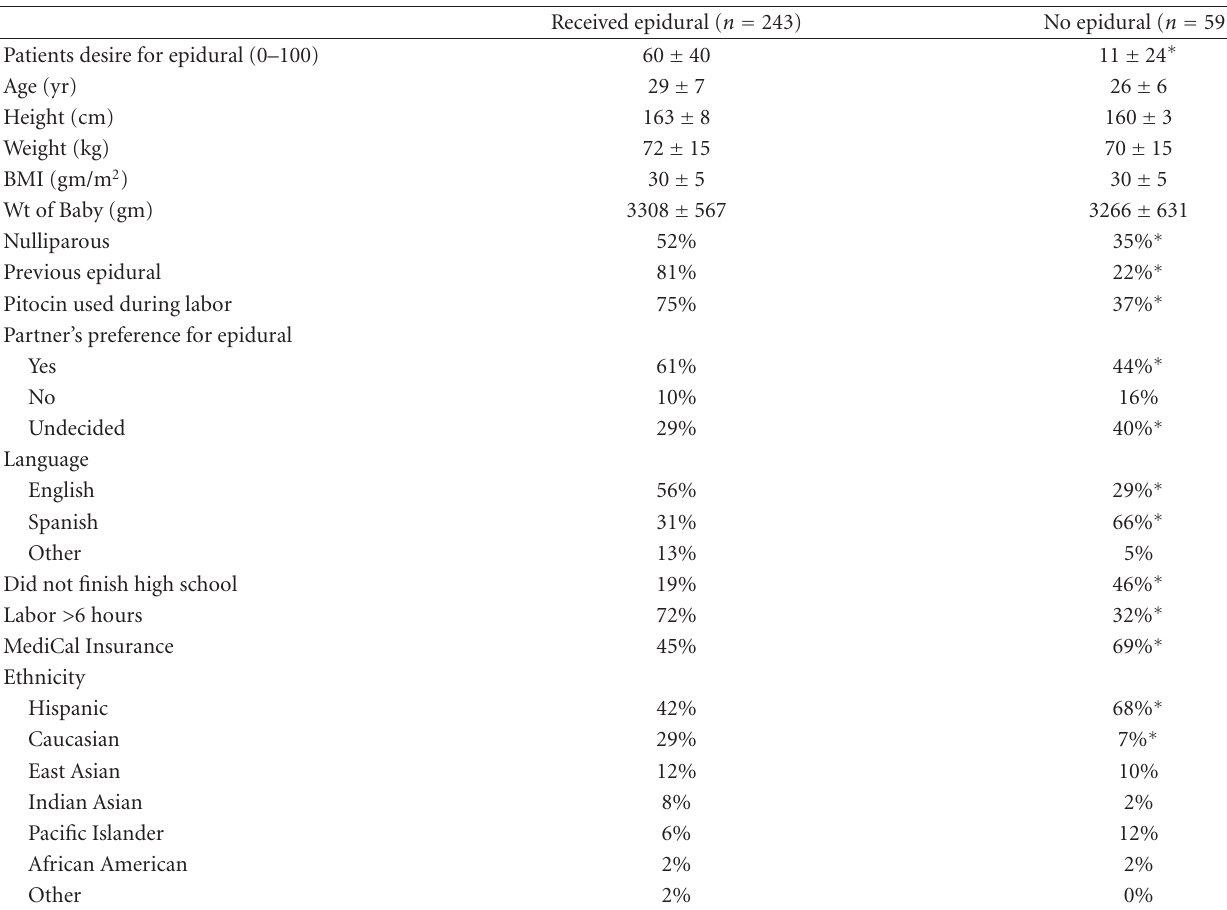
Table 1: Demographics, obstetric data as well as patient and partner desire for labor epidural.